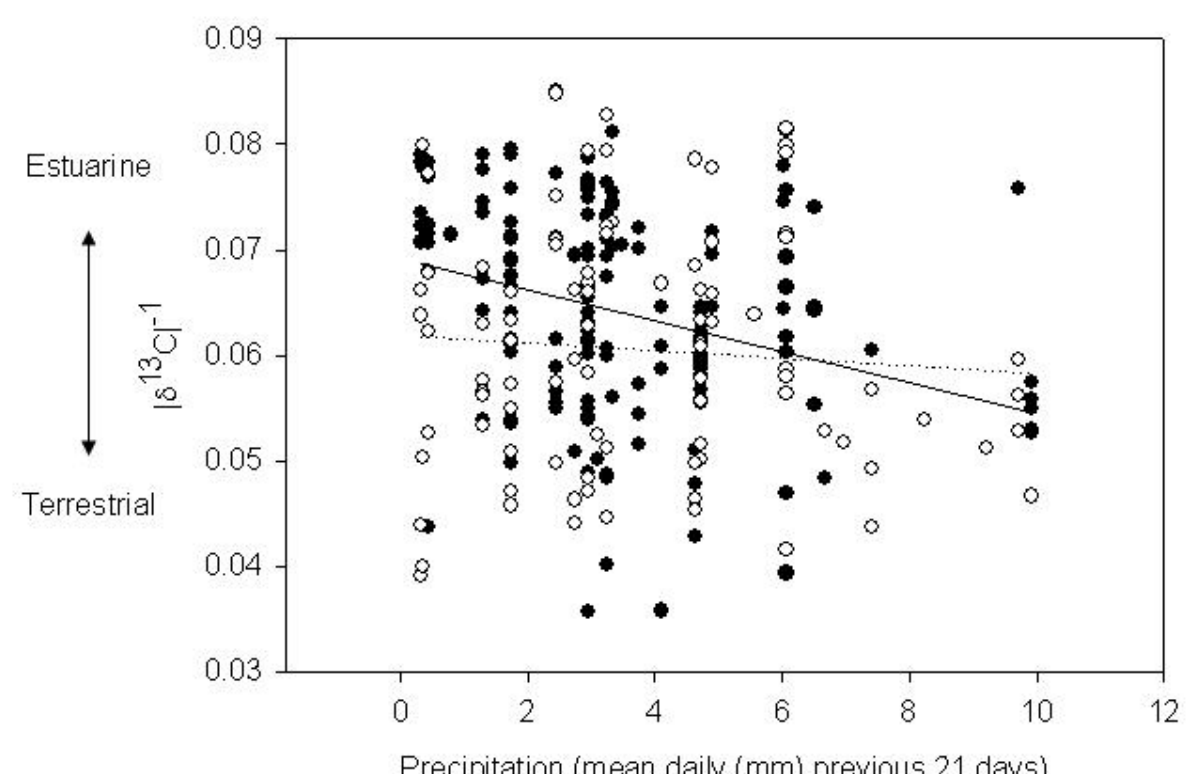
Fig. 6 . Relative use of fields (as represented by transformed d 13 C values) and mean total precipitation for previous 21-d period, separated by age class, adults represented by black filled circles, juveniles by open circles. The Y-axis represents a transformation of d 13 C data (| d 13 C| -1 ) and is an index of relative use of each ecosystem (estuarine versus terrestrial) in Dunlin diet. ASY refers to after-second-year birds, and SY to second-year birds. The linear regression line of significantly increasing field use with increasing precipitation is shown in black for adults. The dotted line shown for juveniles is for comparison only and is not significant. [ See